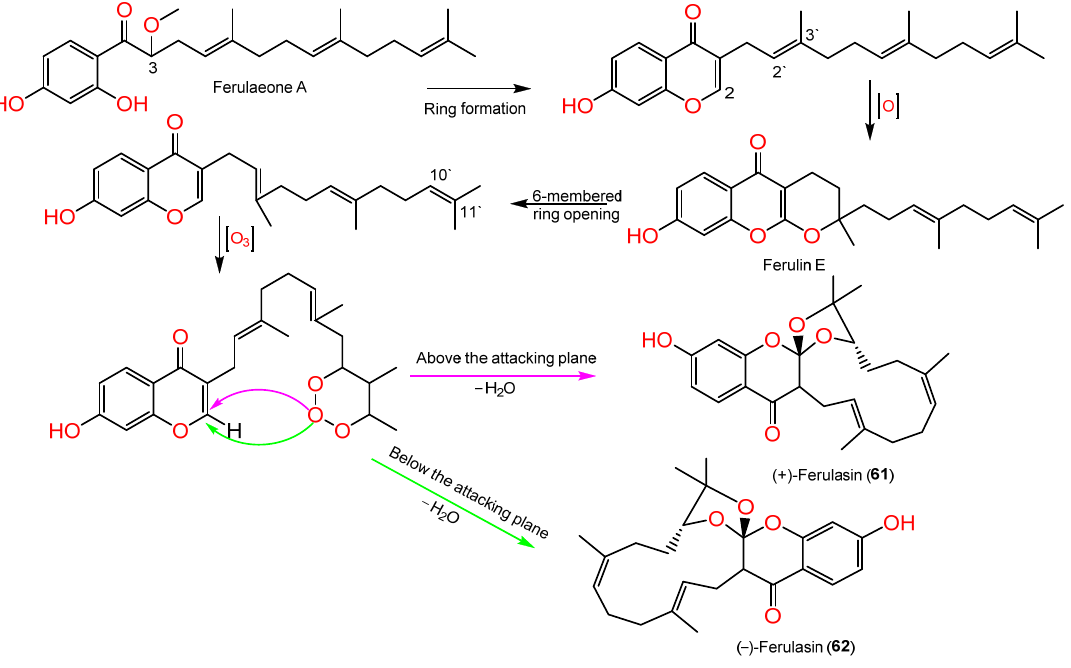
Scheme 1. Biosynthetic pathway of ( ± )-ferulasin